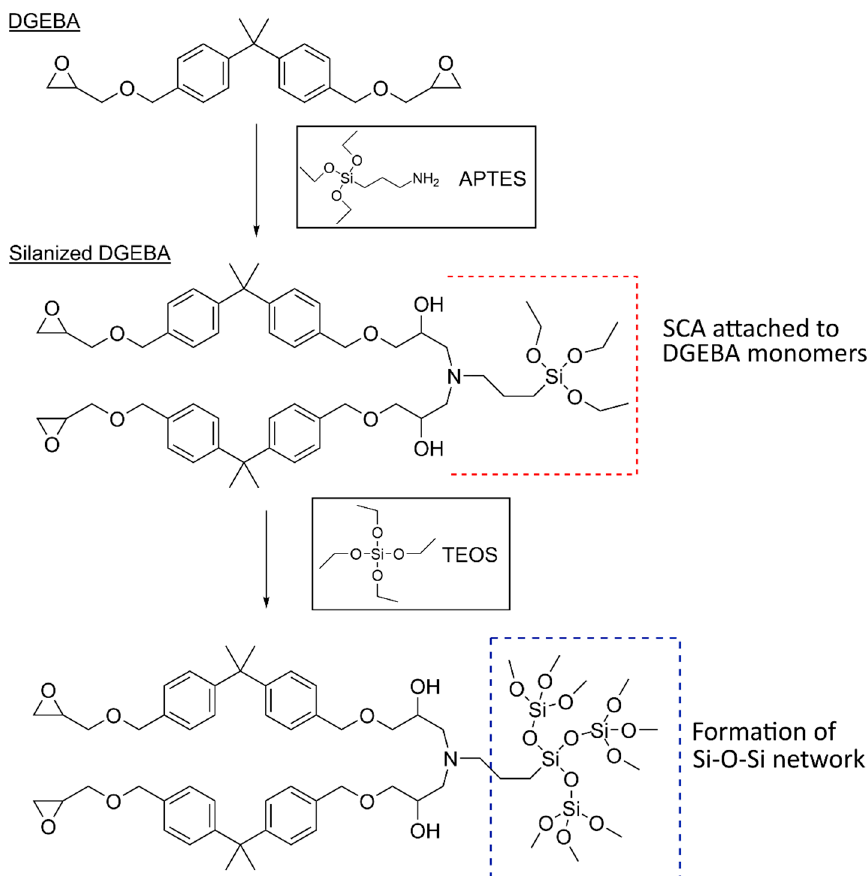
Figure 5. Schematic of the in situ sol–gel reactions possibly occurring in the ‘chronological’ two-step procedure for the preparation of epoxy–SiO 2 nanocomposites. Diglycidyl ether of bisphenol A (DGEBA) is used as the epoxy monomer, 3-aminopropyltriethoxysilane (APTES) as the coupling agent, and tetraethylorthosilicate (TEOS) as the silica (SiO 2 ) precursor. The curing step is not shown in this schematic.